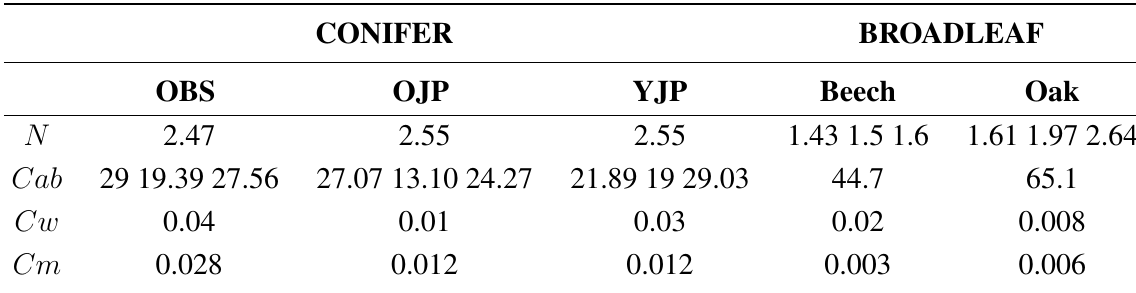
Table 1. PROSPECT input parameters. N is the leaf structure parameter; C chlorophyll a + b concentrations ( µg/cm 2 ); Cw is the equivalent water thickness ( g/cm 2 ); and Cm is the dry matter content ( g/cm 2